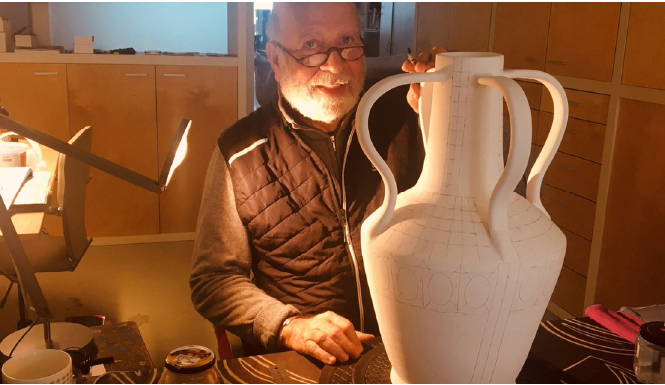
Figure 17. Rachid Koraïchi producing the series “Lachrymatoires Bleues” (Blue Lachrymatory Vases) (ii). 2020. Ceramic with cobalt oxide underglaze, 51 × 31 × 32 cm (RK5050). Screenshot from